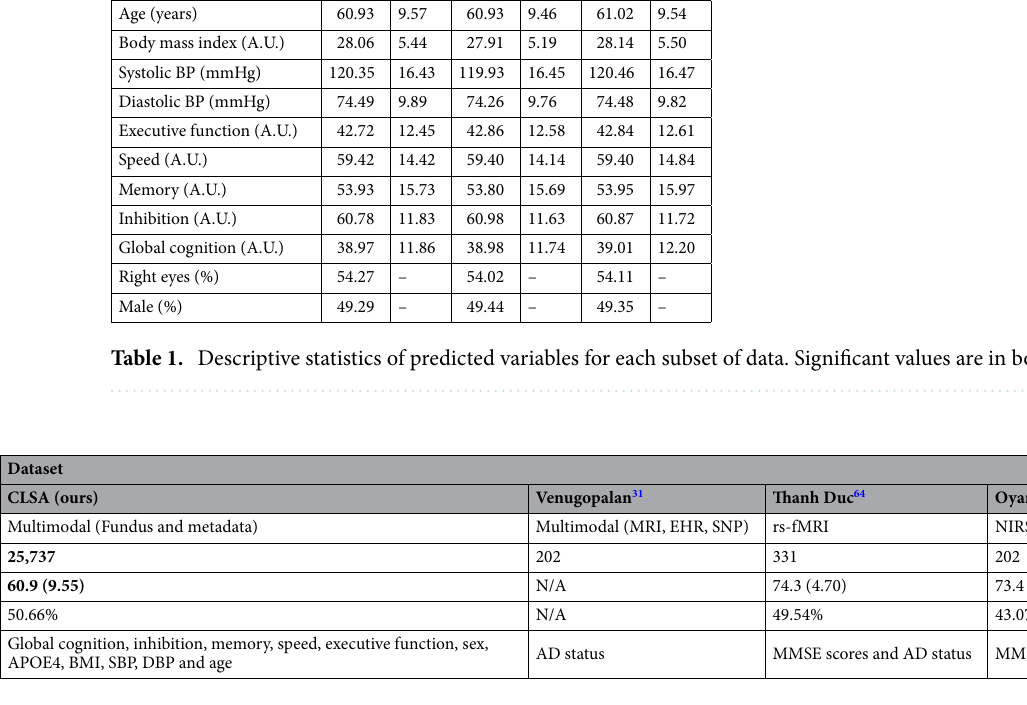
Table 2. Difference between CLSA subset and similar works aiming to predict cognition related measurements. Values from cohorts other than CLSA are reported from corresponding papers. Mean and standard deviation are reported for numerical values. Significant values are in